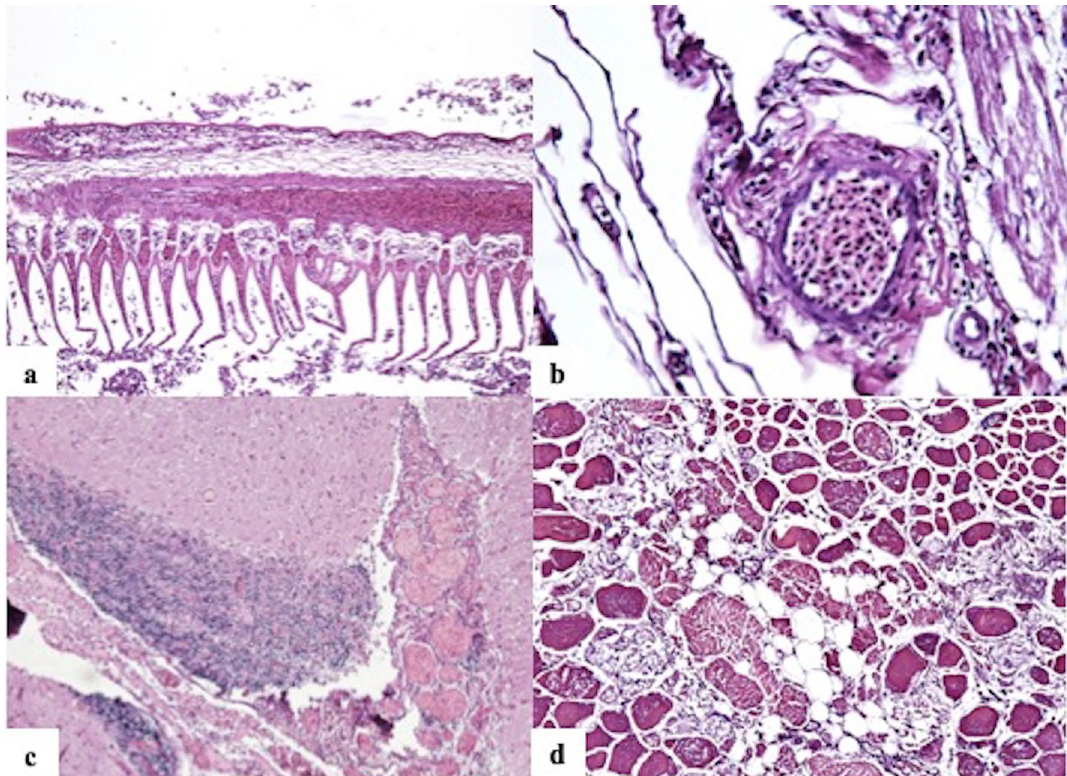
Figure 2. Main histological lesions. ( a ) Moderate to severe diffuse congestion and epithelial sloughing, gills, common carp. Hematoxylin–eosin (HE), ×4 magnification. ( b ) Diffuse severe congestion of cardiac and coronary arteries, heart, common carp. HE, ×40 magnification. ( c ) Diffuse moderate to severe vascular congestion of encephalic vessels and choroid plexus associated with perivascular infiltrate of glial cells, brain, common carp. HE, ×4 magnification. ( d ) Multifocal to coalescing, severe Zenker’s necrosis, skeletal muscle, common carp. In the necrotic areas, loss of cross striations and nuclei, hyaline appearance of the cytoplasm, and fragmented fibers are evident. HE, ×20 magnification.